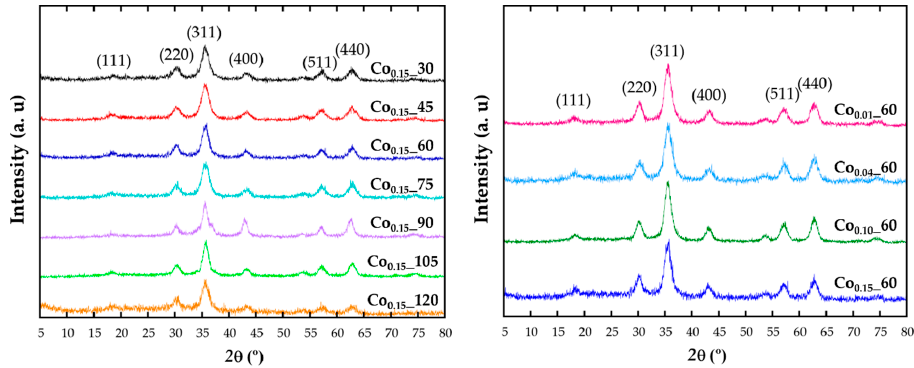
Figure 1. X-ray diffraction pattern of the samples obtained with different reflux times ( left ) and at varying the cobalt content ( right ).